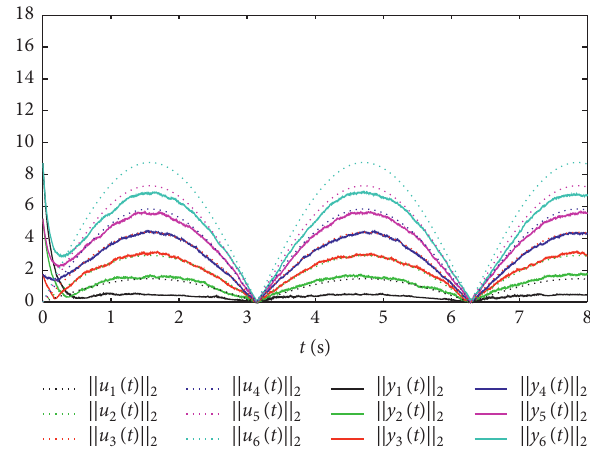
Figure 4: The norms of the input and output vectors ‖